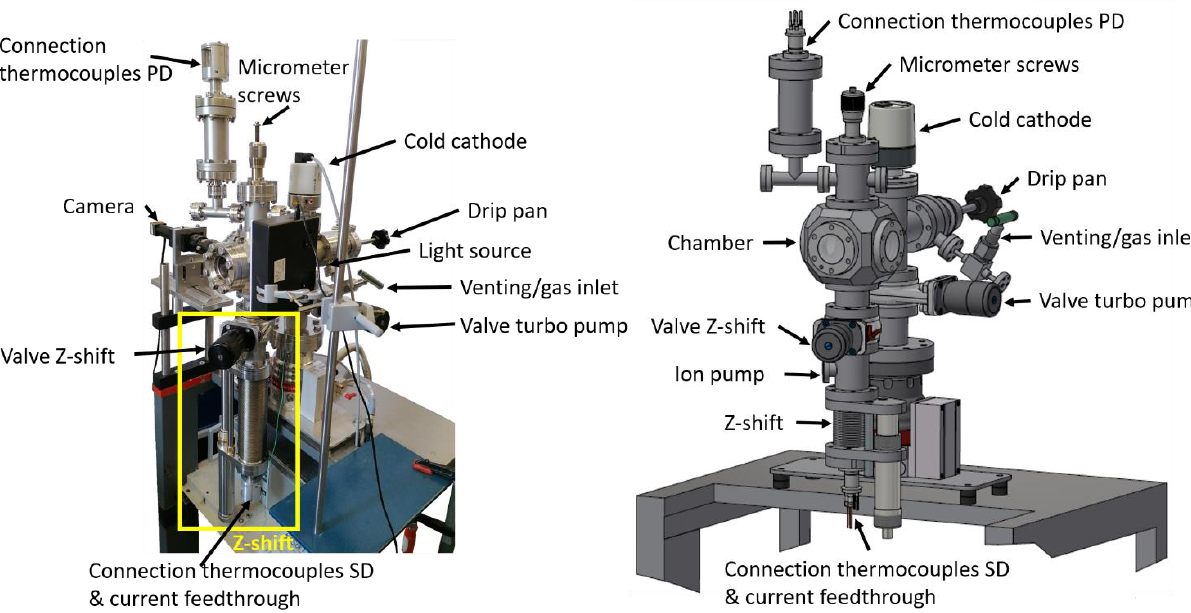
Figure 1. Photograph (left) and drawing (right) of the whole vacuum PD/SD